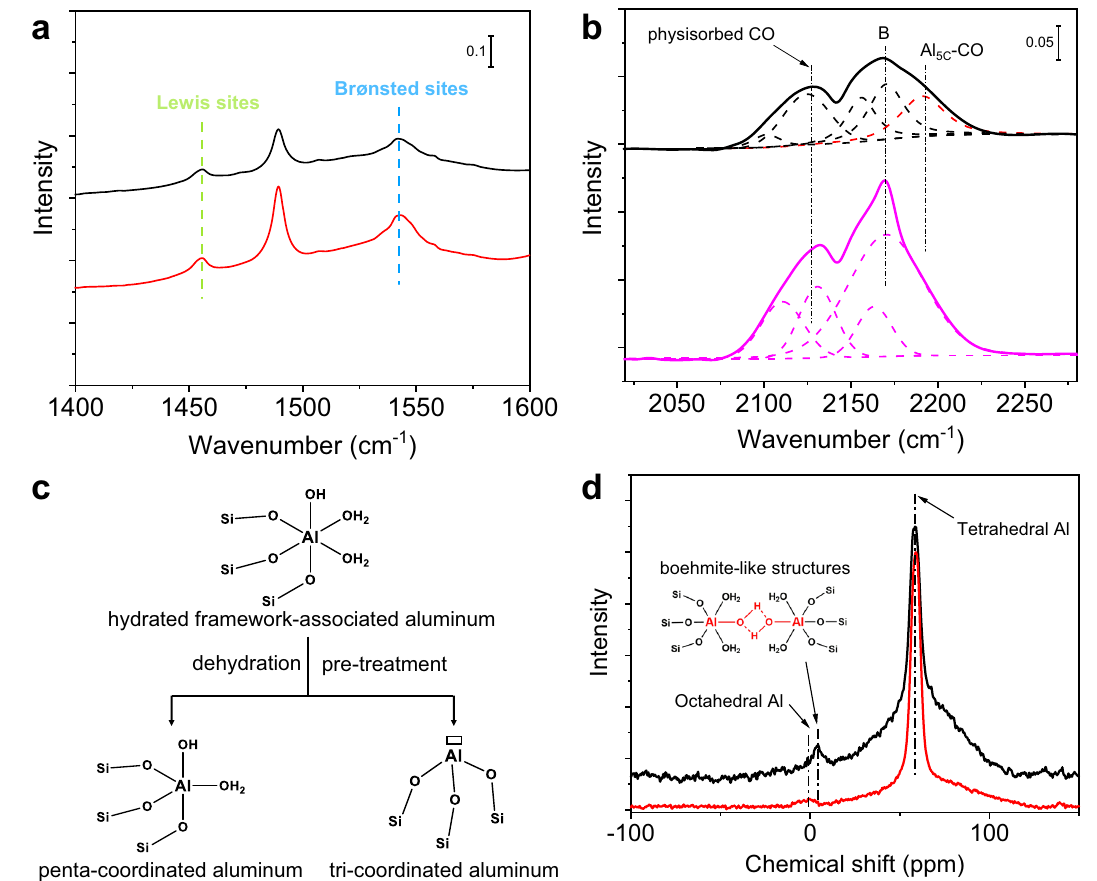
Fig. 3 Acidity and aluminum characterization of zeolite catalysts. a FTIR spectroscopy of adsorbed pyridine in ZSM-5-MT (black line) and ZSM-5-Sb-67 (red line). b FTIR spectroscopy of adsorbed CO in ZSM-5-MT (black line) and ZSM-5-Sb-67 (pink line). c Structural evolution of tri-coordinated Al FR LASs under different conditions. d 27 Al MAS NMR of ZSM-5-MT (black line) and ZSM-5-Sb-67 (red